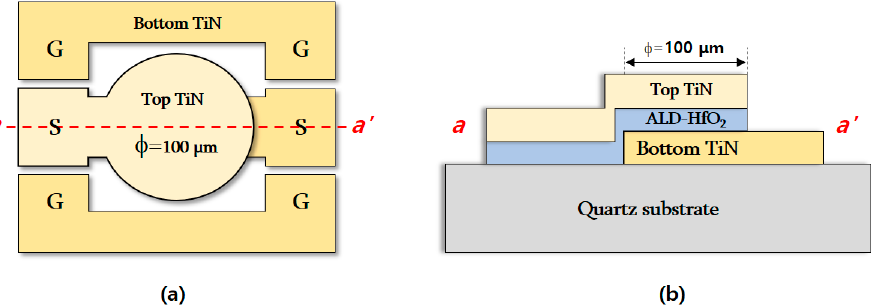
Figure 1. ( a ) Top view and ( b ) cross-sectional schematic along a–a’ of TiN/undoped HfO 2 /TiN MFM capacitor fabricated on a quartz substrate.